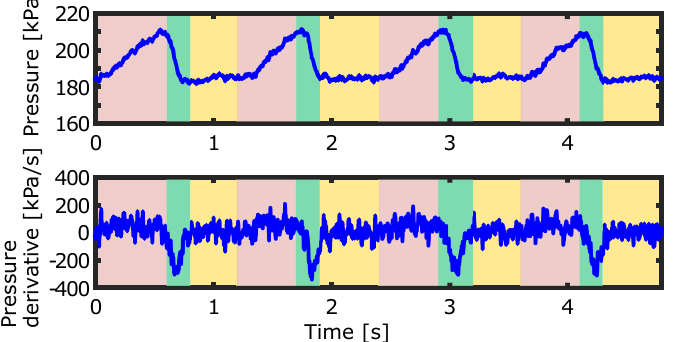
Figure 8. Sample experimental data with the initial pressure of 200 kPa. The trainee walked with its walking rate 100 BPM. The horizontal axis shows time (s), and walking phases are distinguished by color areas. Red areas represent the stance phase, green areas represent the pre-swing phase, and yellow areas represent the swing phase. The ( upper ) figure shows the pressure in the RCB PARM. The ( lower ) figure shows the pressure derivative.